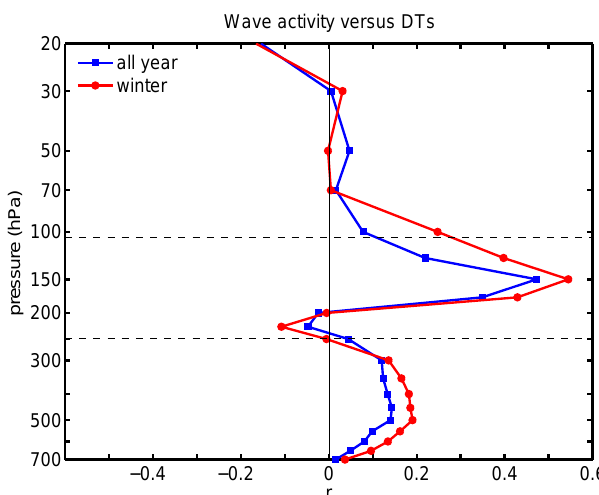
Fig. 2. Correlation between the area covered with DTs in the NH and the area weighted average of the quasi-geostrophic wave activity, A , in the latitudinal band 30–50 ◦ N. The blue curve represents the correlations considering all months, and the red curve represents the correlations for the winter (November–March) months. The horizontal dashed lines mark the mean log pressure height of the first and second lapse rate tropopauses in the latitudinal band 30–50 ◦